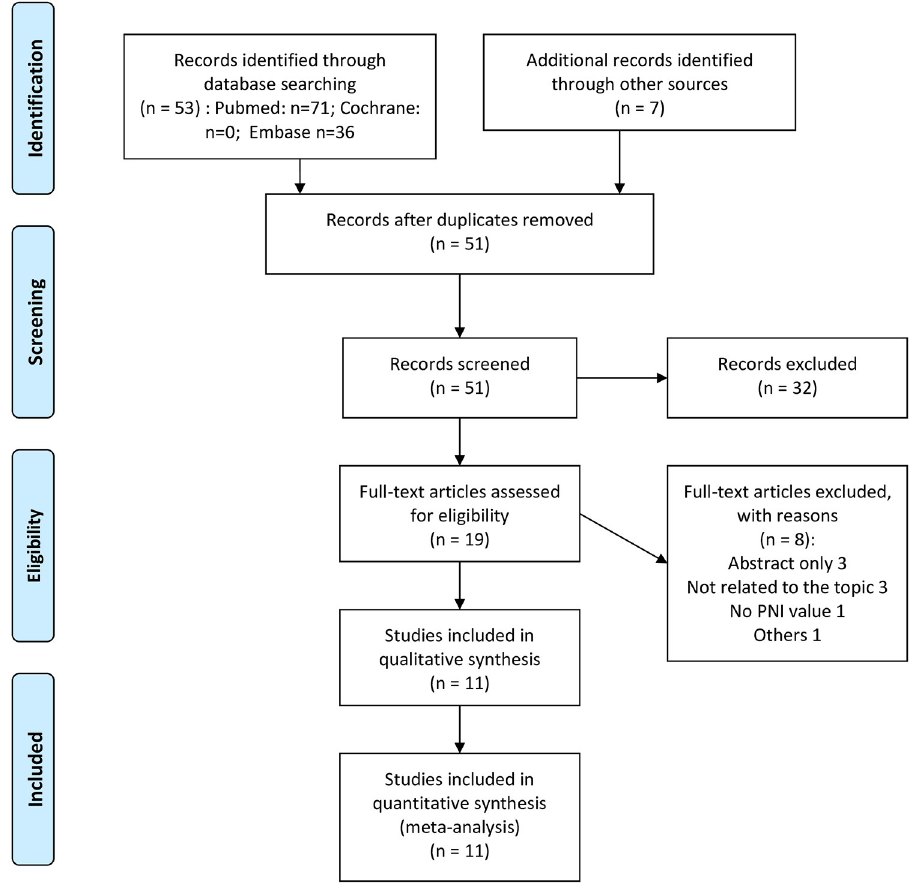
Fig 1. Flow diagram of studies identified in meta-analysis. PNI indicates Prognostic Nutritional